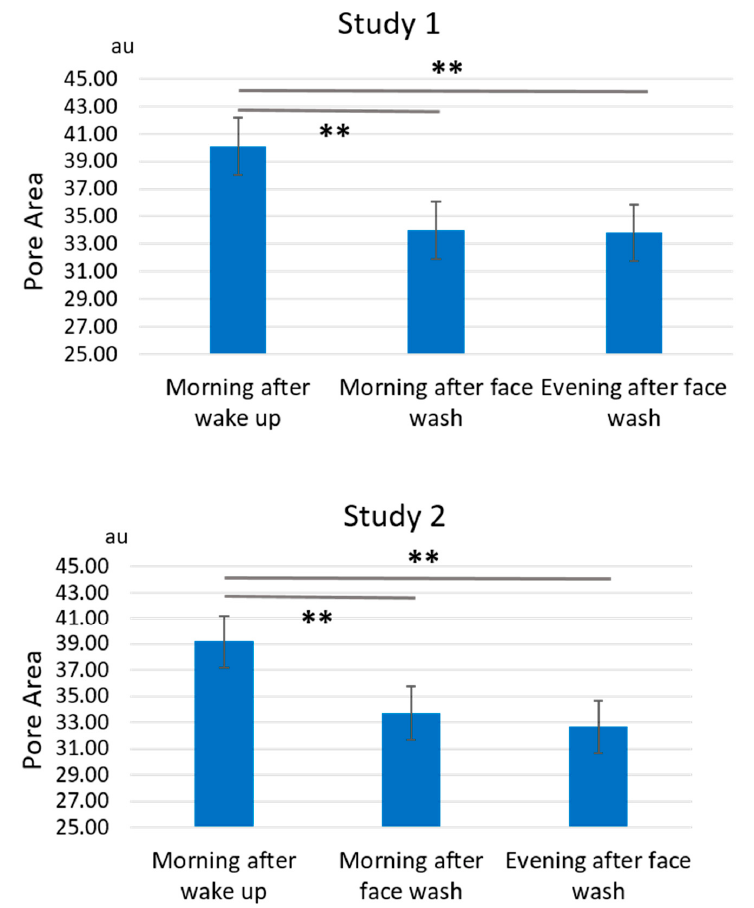
Figure 4. Daily fluctuation of pore area. Facial pore area is significantly larger during the morning after wake ‐ up than during the morning after face wash or during the evening after face wash in both Study 1 and Study 2 at baseline period week ‐ 4 to week ‐ 1. **; p < 0.01. In order to better compare the morning ‐ to ‐ evening fluctuation in the baseline measurement period, we plotted weekly average values of the pore area (Figure 5).